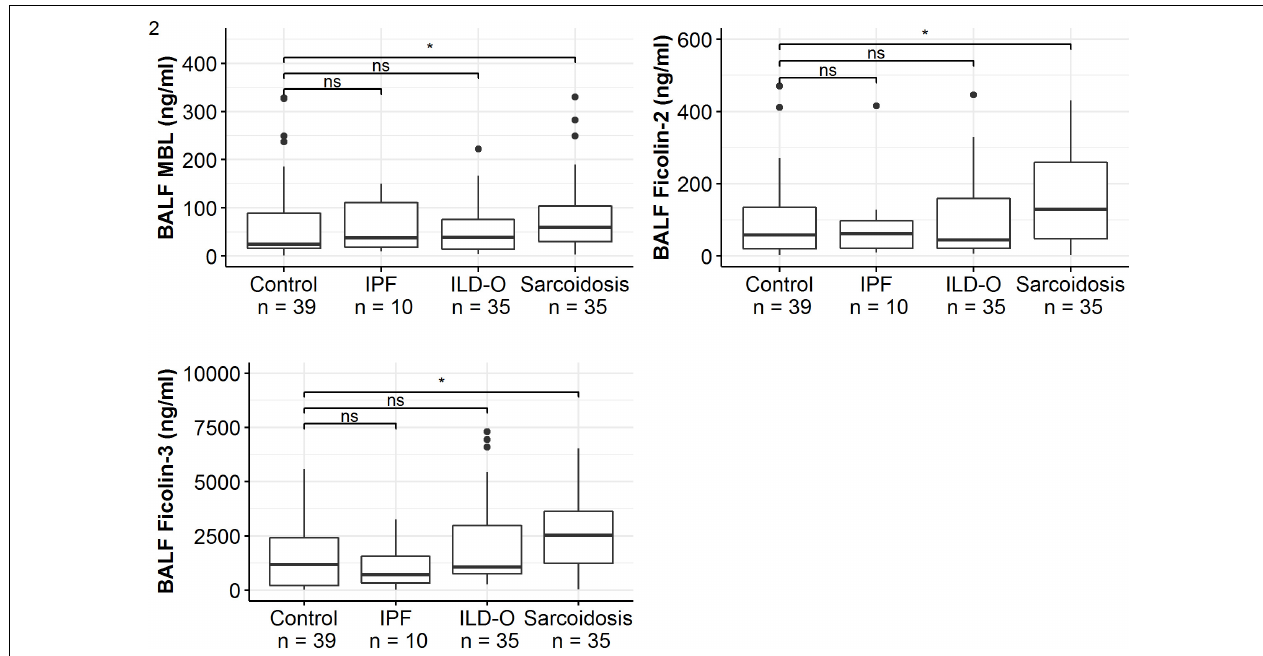
FIGURE 2 | BALF lectin concentrations of idiopathic pulmonary fibrosis (IPF), non-IPF patients other sarcoidosis (ILD-O), sarcoidosis and control patients. Horizontal bars with a star denote statistically significant comparisons ( p -value < 0.05) whereas bars annotated with “ns” denote non-significant comparisons (Mann–Whitney U test).